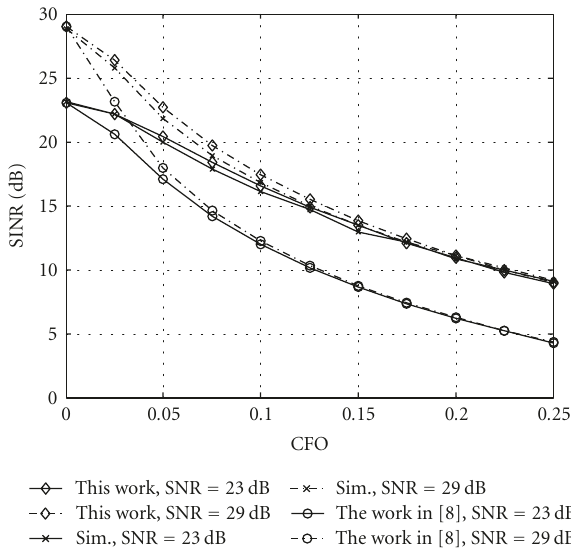
Figure 2: SINR plotted against CFO, under SNR = 23 and 29 dBs.